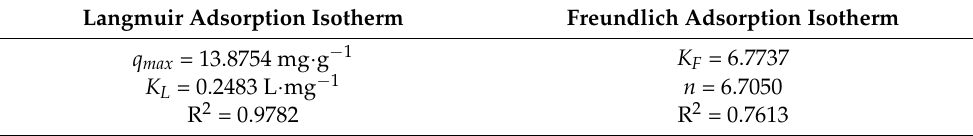
Table 3. Constants of Langmuir and Freundlich